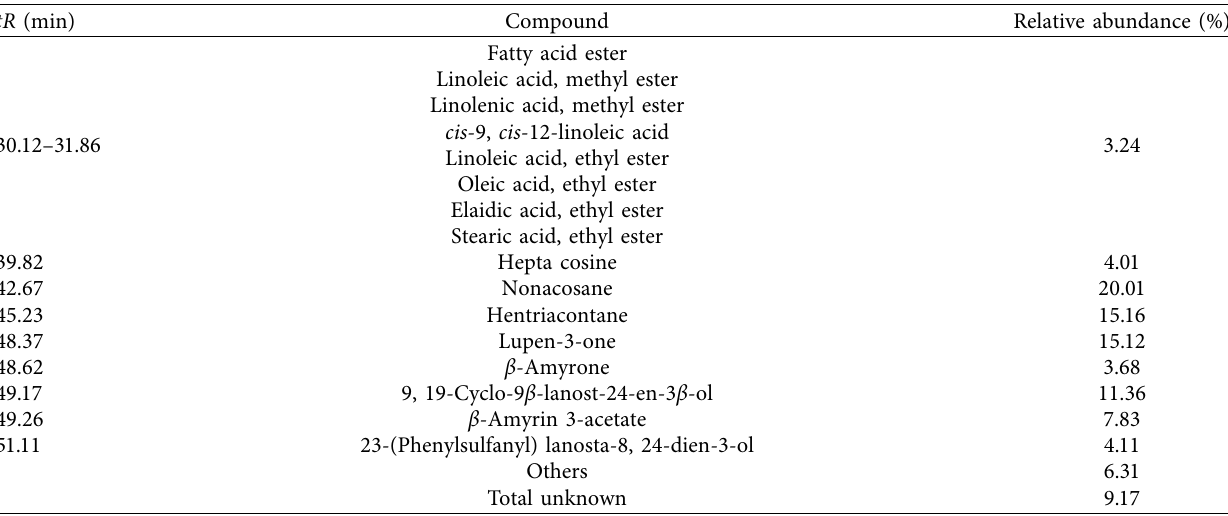
Table 3: Tentative compounds found in stingless bee wax.